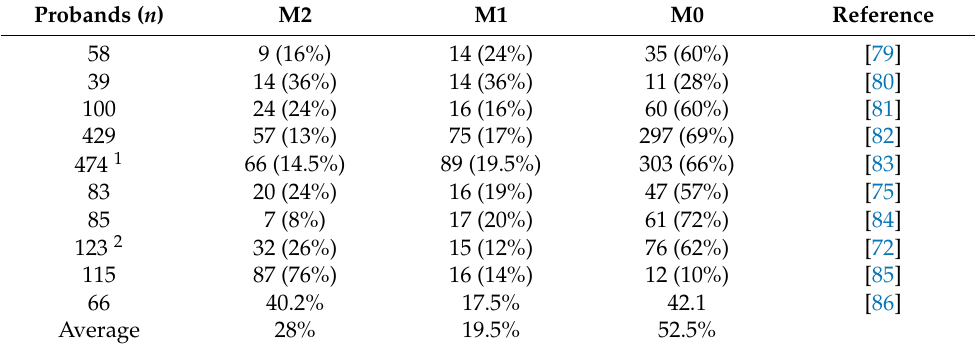
Table 1. Prevalence of SLC26A4 mutations in large ( n > 30 individuals) EVA cohorts with a predomi- nant Caucasian ethnicity. The number and % of patients with biallelic (M2), monoallelic (M1), or no mutations (M0) in the SLC26A4 gene in a given cohort is